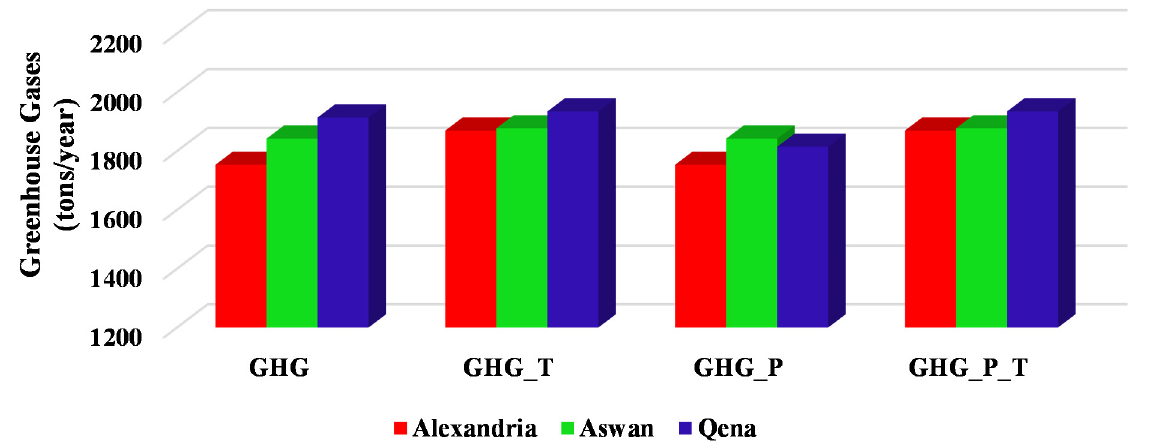
Figure 13. The different amounts of GHG emitted from a PV/diesel/battery system in Alexandria, Aswan and